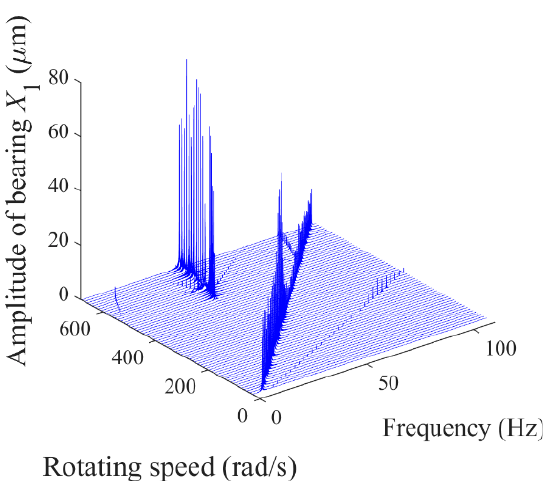
Figure 11. Frequency waterfall chart of the rotating shaft along a vertical direction at oil pressure of 0.2 MPa.